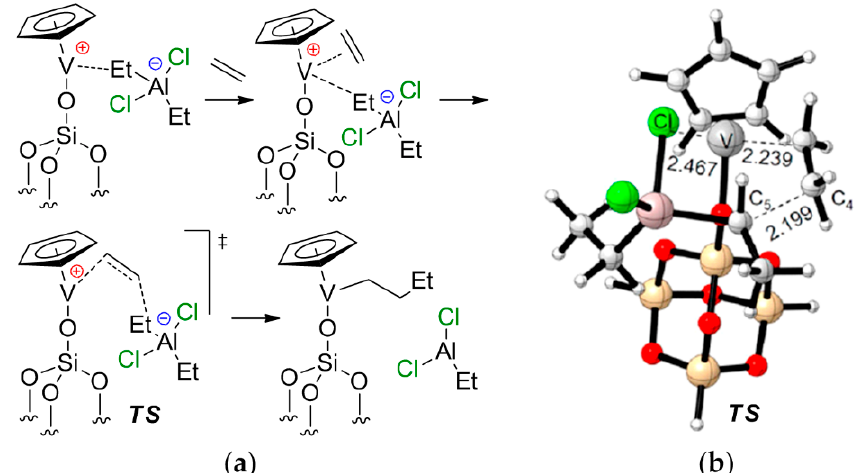
Figure 26. ( a ) Proposed mechanism of ethylene coordination/insertion on the supported CpV– Et 2 AlCl complex; ( b ) optimized geometry of the key transition state. Reprinted with permission from [217]. Copyright (2020) Elsevier